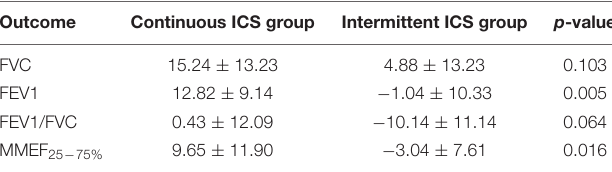
TABLE 7 | Difference in lung function before and after 1 year of treatment (age > 5 years).